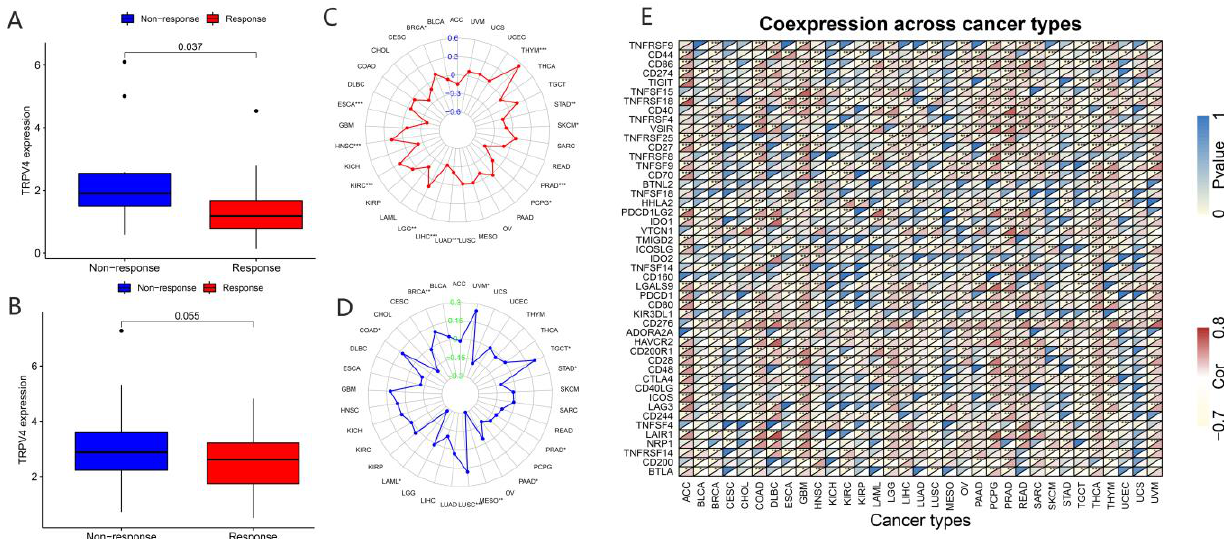
Figure 9. Correlation of immunotherapy outcome, TMB, MSI, and immune-activation-related genes with the expressions of TRPV4. p < 0.05; ** p < 0.01; *** p < 0.001.